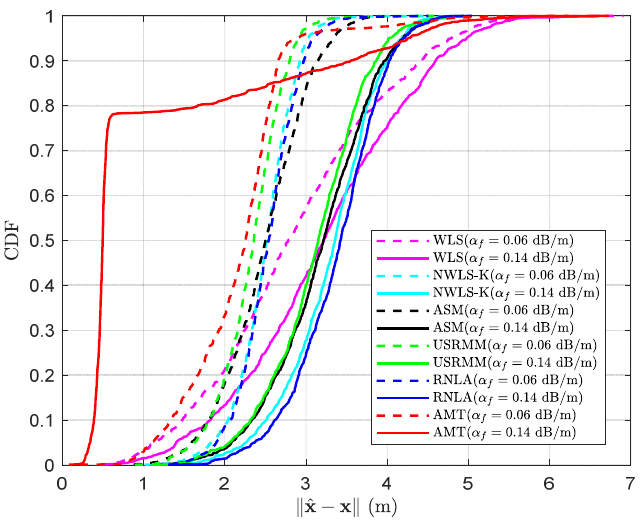
(cid:107) ˆ x − x (cid:107) with N = 10, σ 2